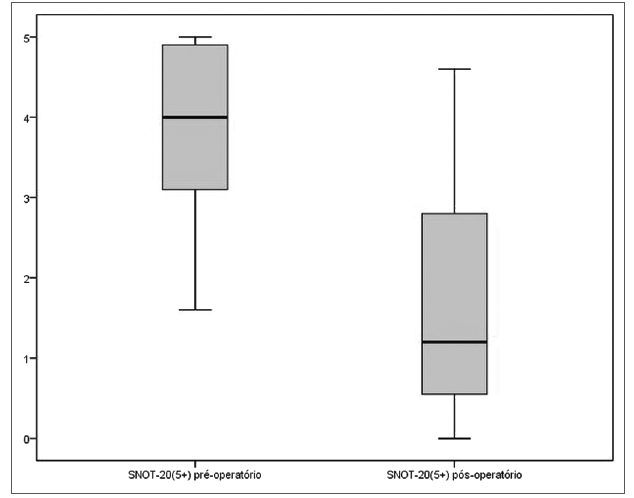
Figura 2. Pontuação pré-operatória e pós-operatória nos cinco itens considerados mais importantes no questionário SNOT-20 ( p <0,001). tuação total do SNOT-20 apresentada em cada sexo ( p =0,484) (Figura